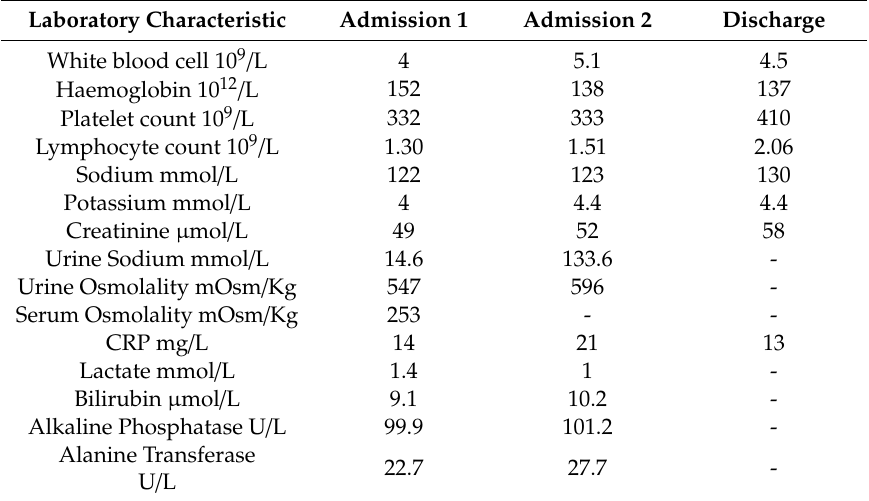
Table 1. Results